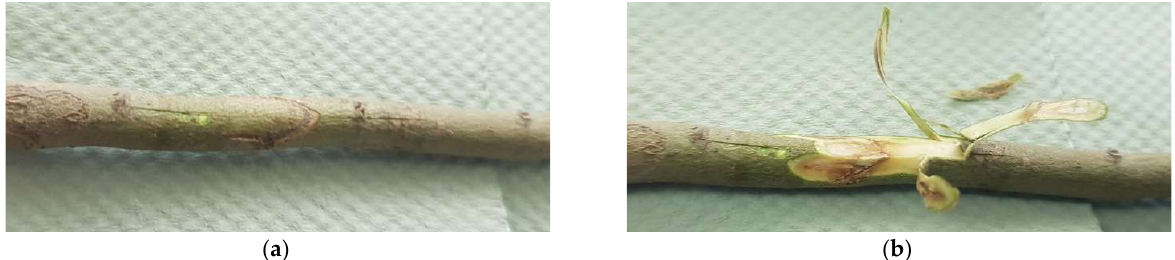
Figure 1. Samples of variant C (+) with visible necrotic lesion ( a ) and variant C (−) with no lesions observed ( b ).